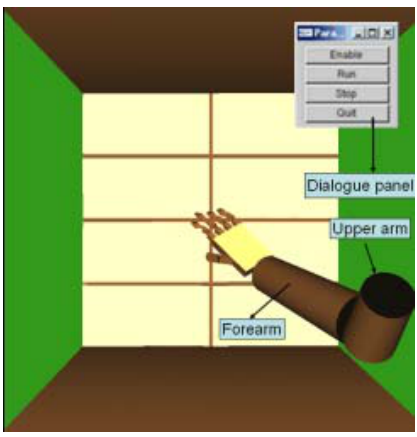
Figure 10. Experimental virtual